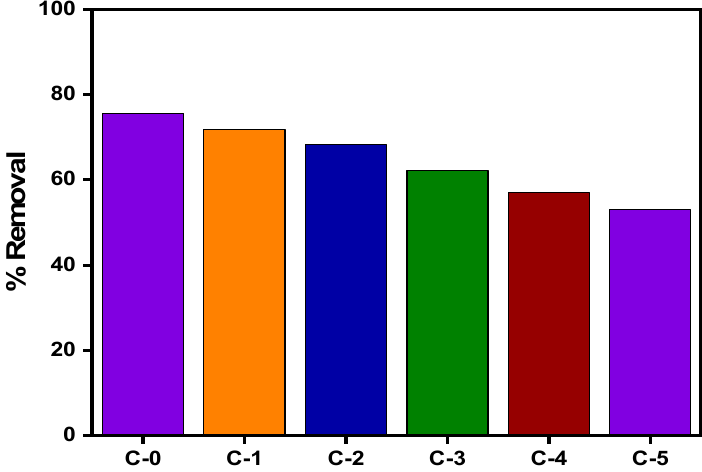
Figure 12. Reusability test of MIP-202/CA composite beads towards diazinon removal